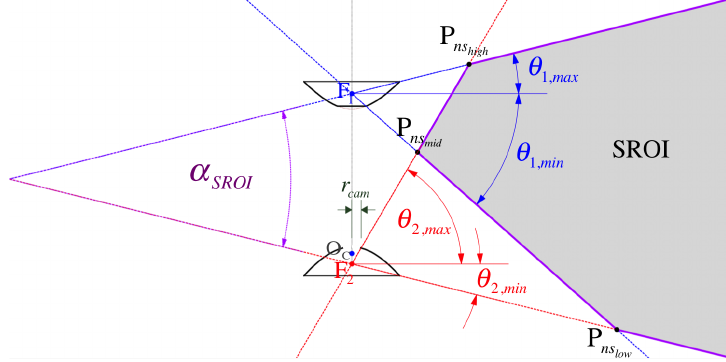
Figure 6. A cross section of the SROI (shaded area) formed by the intersection of view rays for the limiting elevations θ 1/2, min / max . The nearest stereo ( ns ) points are labeled P ns they are the vertices of the hull that near-bounds the set of usable points for depth computation from triangulation (Section 5.2). See Table 3 for the proposed sensor’s